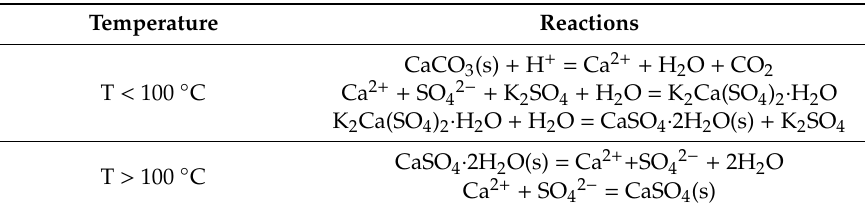
Table 3. A chain reaction from CaSO 4 · 2H 2 O to CaSO 4.